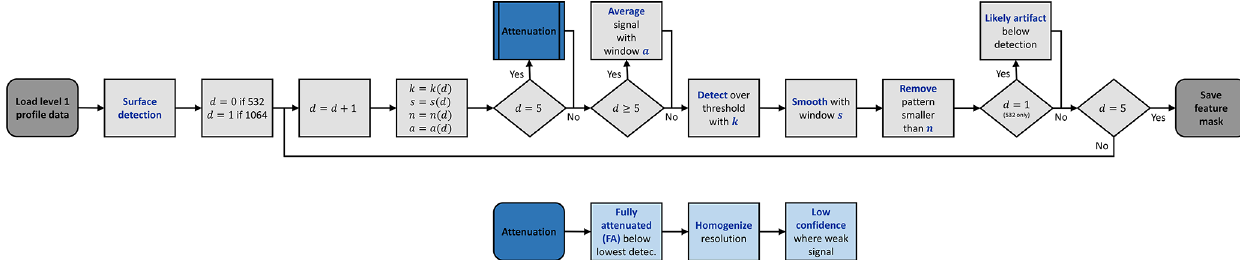
Figure 4. Flowchart of the two-dimensional and multi-channel feature detection algorithm (2D-McDA). d is the detection step, k is the number of total noise standard deviations used in the detection threshold Eq. (3), s is the size of the window used for the spatial coherence test, n is the minimum number of pixels in each pattern, and a is the size of the averaging window. See the algorithm description in Sect. 3 and the coefficient values in Table